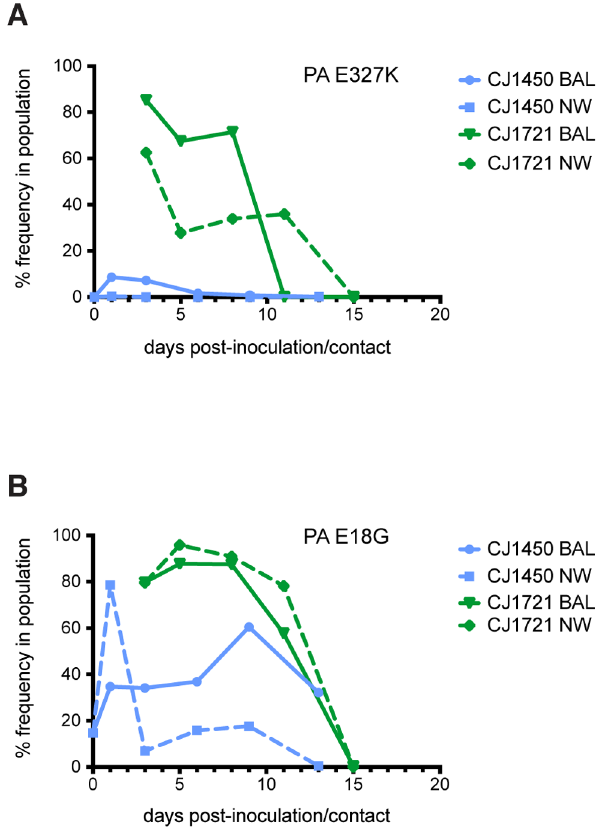
Figure 6. Variants present at both low and high frequencies are transmissible. (A) PA E327K was present in less than 10% of the viruses replicating in the index animal but was present at a high frequency in both the lung and nasal secretions of CJ1721 shortly after transmission. This variant frequency declined in CJ1721 after transmis- sion. (B) PA E18G was present at a frequency around 80% in CJ1721 directly after transmission, but declined over the remainder of the